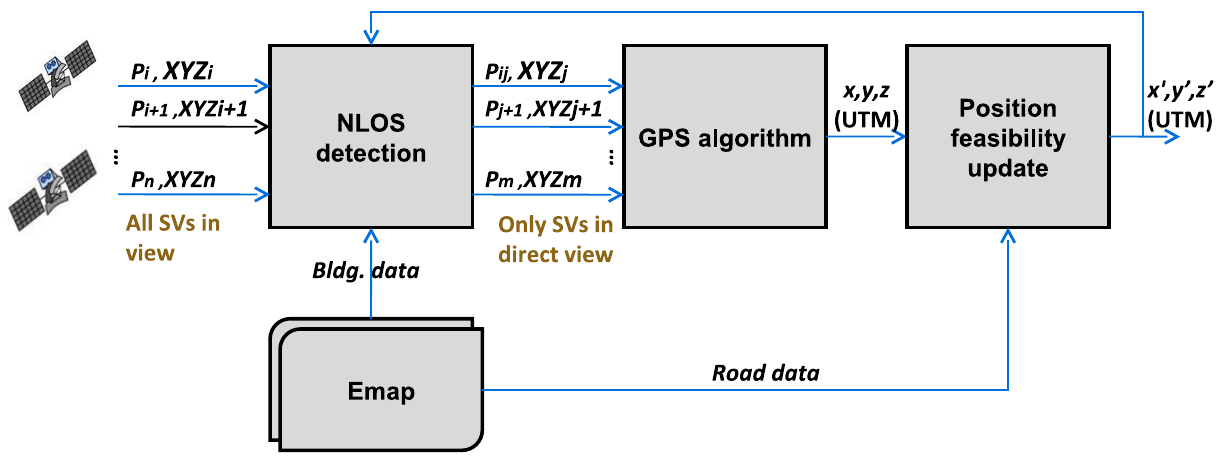
Figure 2. Positioning loop with the NLOS algorithm, the GPS algorithm and the position feasibility